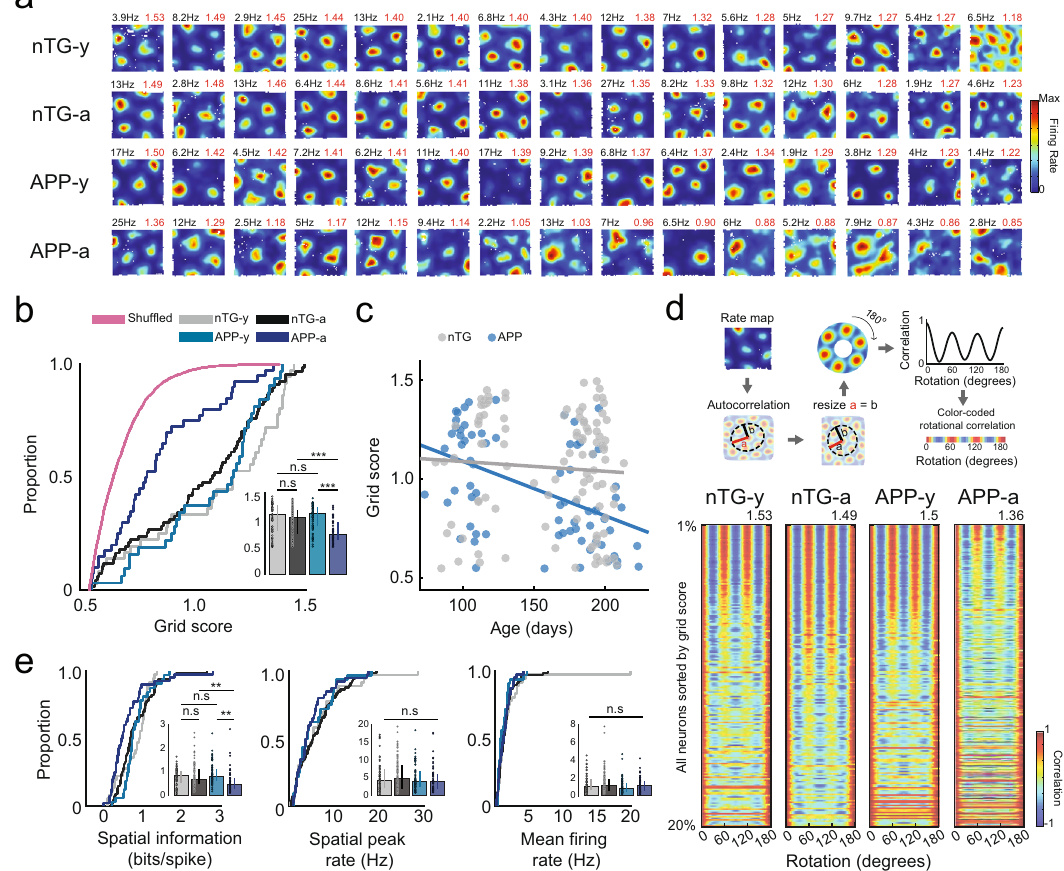
Fig. 1 Reduction of grid cell spatial periodicity in adult APP transgenic mice. a Firing rate maps for grid cells from each experimental group. Each row includes 15 grid cells with the highest grid scores sorted in descending order. Spatial peak fi ring rate and grid score are indicated in the rate map ’ s top-left and top-right, respectively. b Grid scores (nTG-y-nTG-a: P = 0.12; nTG-y-APP-y: P = 0.73; APP-y-APP-a: P = 1 × 10 − 7 ; nTG-a-APP-a: P = 2.5 × 10 − 6 ) between groups (cells, n = 64 nTG-y; n = 99 nTG-a; n = 74 APP-y; n = 50 APP-a). c Scatter plot displays grid score by age (in days) recorded. A two- way ANOVA examined the effects of age and genotype on grid score. There was a signi fi cant interaction between age and genotype: F (1, 280) = 11.99, P = 6.2 × 10 − 4 . d Color-coded rotational correlations are shown, sorted in descending order of grid score. Neurons within the top 20% of grid scores are shown. The max grid score in each group is displayed at the top of the respective plot. e Spatial information (nTG-y-nTG-a: P = 0.77; nTG-y-APP-y: P = 0.34; APP-y-APP-a: P = 6.5 × 10 − 6 ; nTG-a-APP-a: P = 1.2 × 10 − 3 ), spatial peak fi ring rate (nTG-y-nTG-a: P = 0.59; nTG-y-APP-y: P = 0.79; APP-y-APP- a: P = 0.77; nTG-a-APP-a: P = 0.27), and mean fi ring rate (nTG-y-nTG-a: P = 0.99; nTG-y-APP-y: P = 0.086; APP-y-APP-a: P = 0.13; nTG-a-APP-a: P = 0.79) between groups (cells, n = 64 nTG-y; n = 99 nTG-a; n = 74 APP-y; n = 50 APP-a). nTG-y non-transgenic young, nTG-a non-transgenic adult, APP-y APP young, APP-a APP adult. Wilcoxon rank-sum tests (two-sided) corrected for multiple comparisons using a Bonferroni-Holm correction were applied to analyze the data in panels b and e . Data in bar graphs are presented as median values ± 25th and 75th percentiles; ** P < 0.01, *** P < 0.001; n.s not signi fi cant. Source data are provided as a Source Data fi